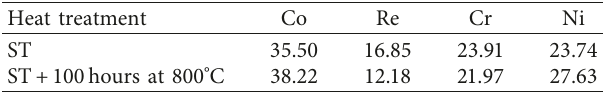
Table 1: Composition of the fcc Co matrix measured on the Co- 17Re-23Cr-25Ni alloy by EDS at positions marked by + in Figure 4. Heat